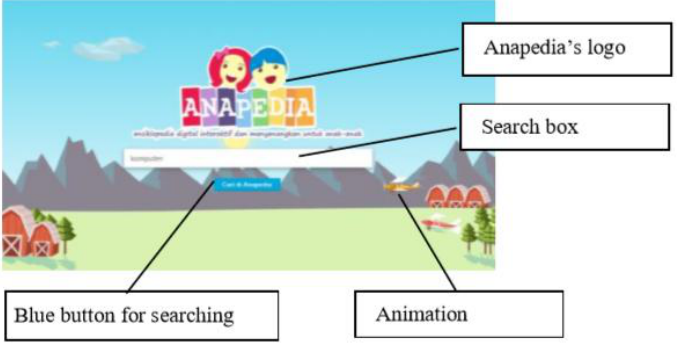
Fig. 5 Full colour start page of